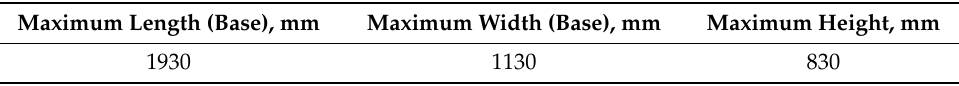
Table 12. Basic dimensions of the proposed